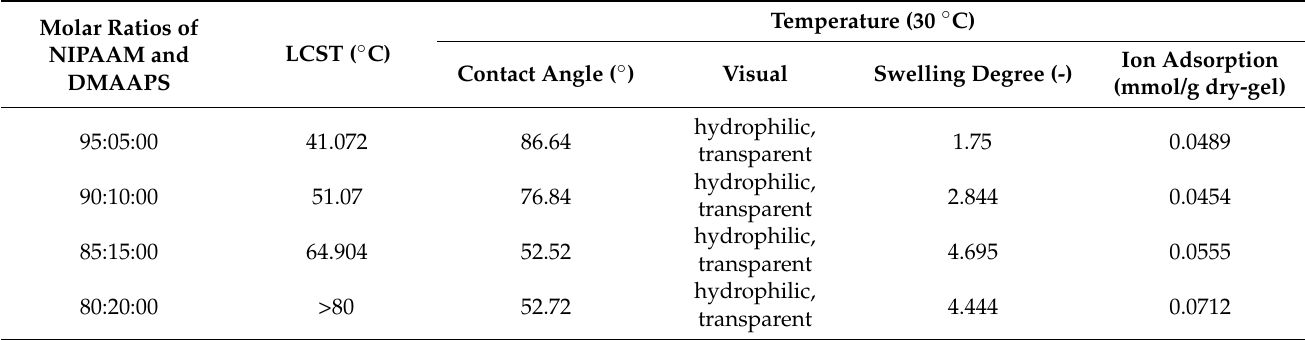
Table 3. Analysis results for co-polymers (phase transition temperature, contact angle, visual) and gels (swelling degree and ion adsorption) with various monomer ratios at 30 ◦ C.